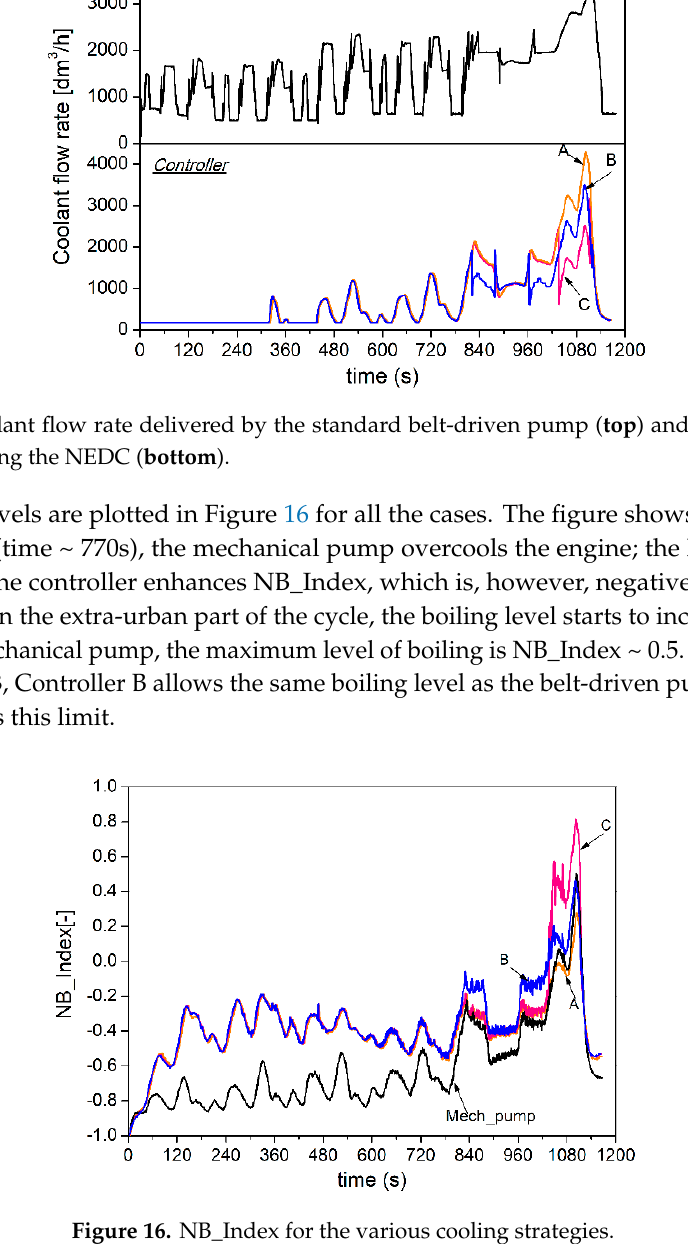
Figure 16. NB_Index for the various cooling strategies.